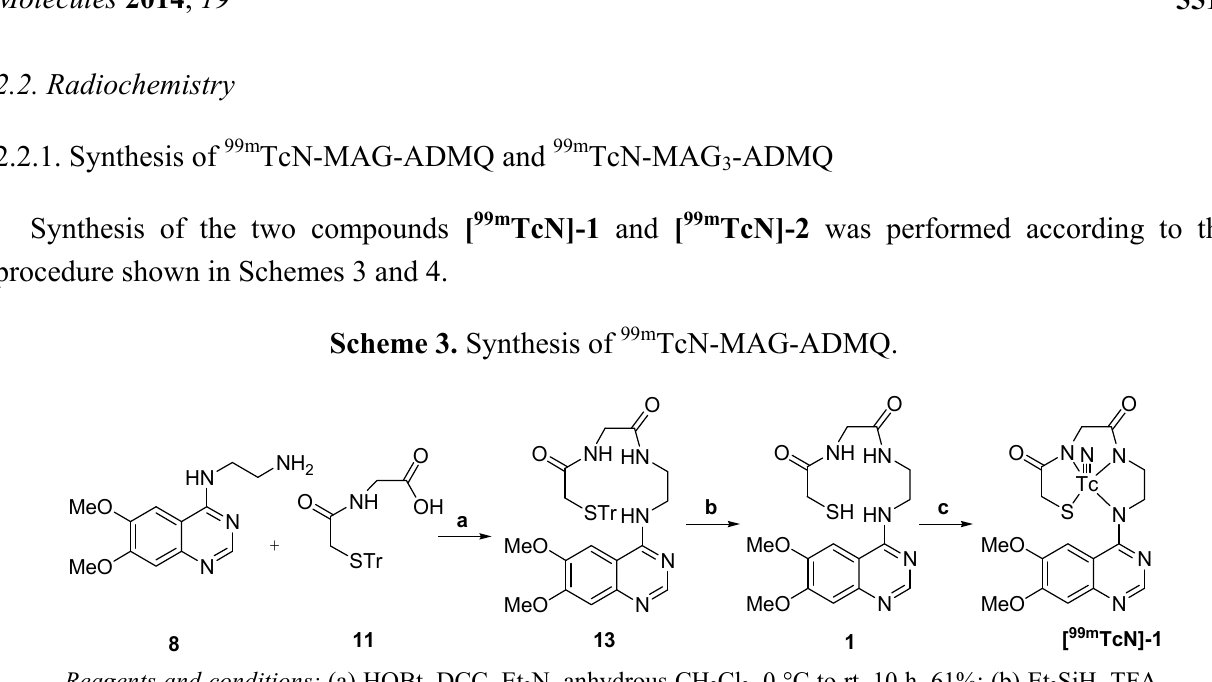
Scheme 4. Synthesis of 99m TcN-MAG